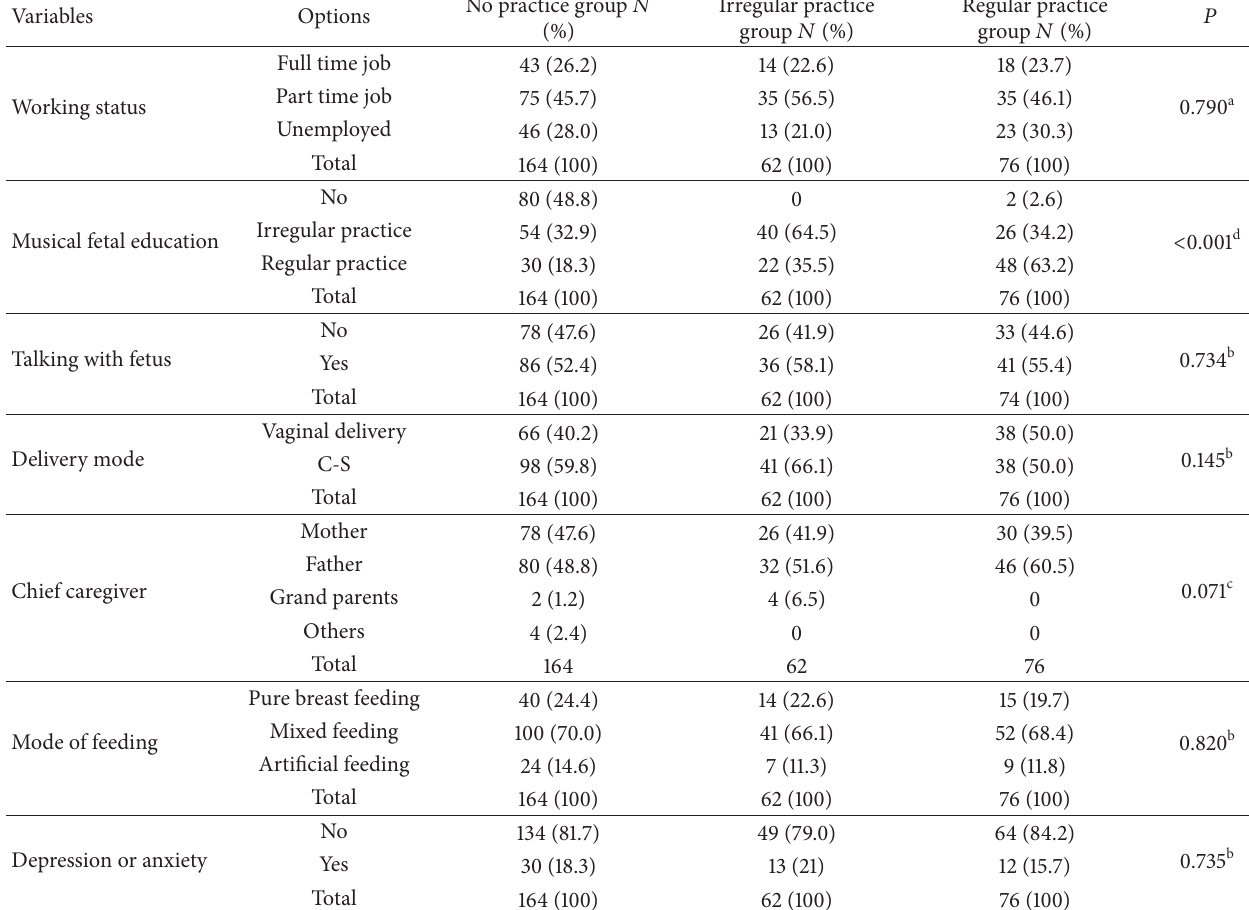
Table 2: The comparison of maternal condition among the three